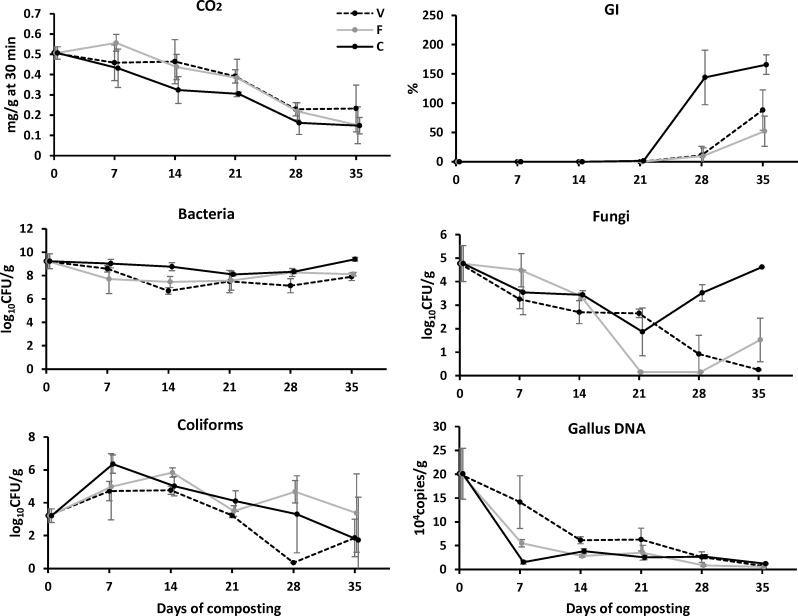
The variation of CO2 respiration rate, germination index, bacterial, fungal and coliform counts, and Gallus-specific DNA copy numbers over 35 d of composting.